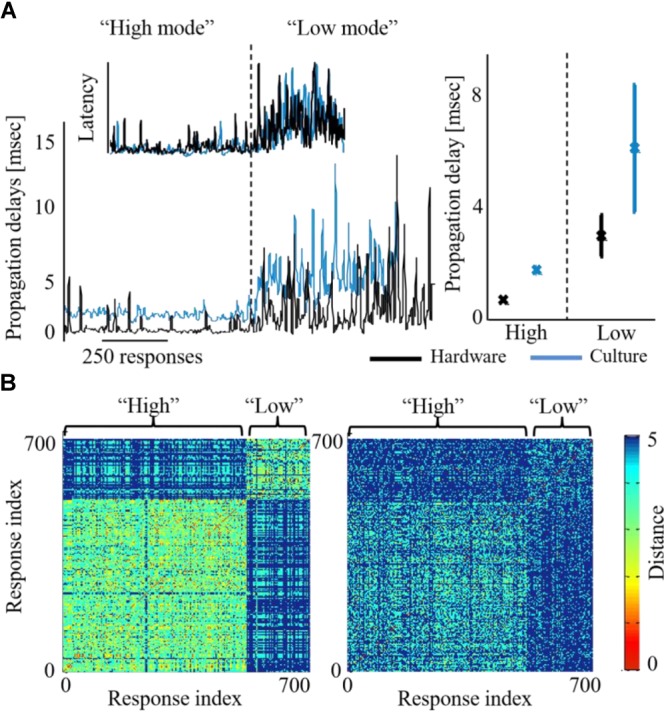
Activity features modified across both biohybrid networks. (A) Propagation delays of synchronizations, under either high or low activity leve l (blue depicts the biological network and black the hardware one). Inset shows the respective alteration of synchronization latency, calculated as the time from stimulation to the synchronization peak. Right panel: average latency values across three coupling experiments, error bars show standard deviation (p < 0.05 in a t-test between the activity levels for both biological and hardware networks). (B) Synchronization recruitment order in the biological (left) and the hardware (right) networks, during high and low activity levels, of a single coupling experiment. Pair-wise difference between propagation paths are presented (calculated with the Levenshtein distance metric), for the first five responding electrodes, across all evoked bursts consecutively [see Shahaf et al. (2008) for details]. The distance between order vectors of evoked burst i and j is color coded in pixel (i,j) between red (0, identical order) and blue (5, no identity in order). Different propagation paths between the high and the low activity levels, would result in a non-homogenous image with two visible squares (where the within-level comparison square has a warmer shade, i.e., lower differences).